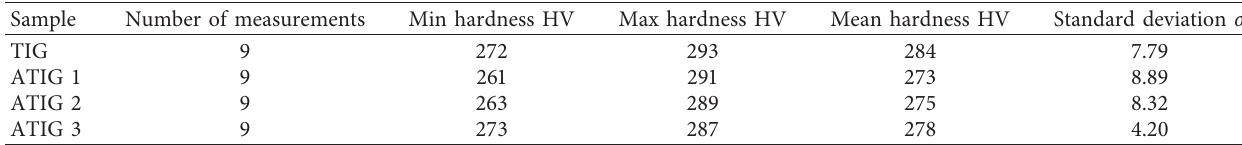
Table 11: Measurements of hardness of TIG and ATIG in FZ.